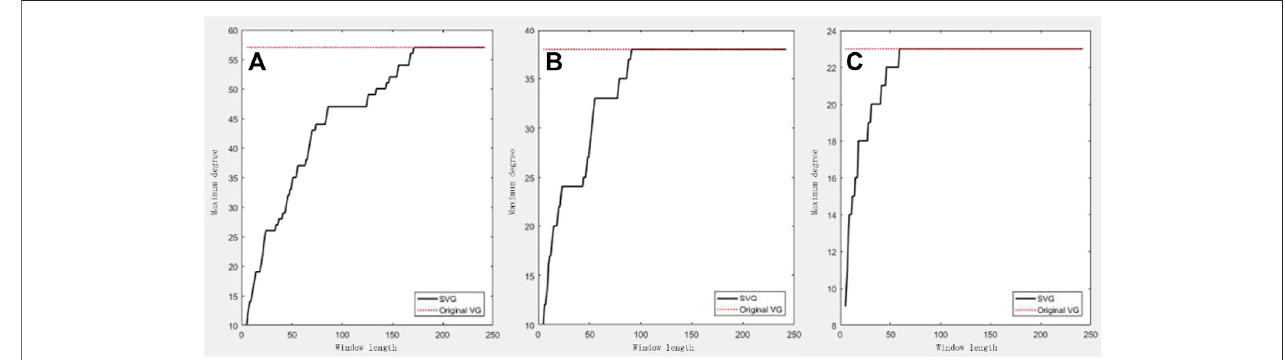
FIGURE4| IllustrationsoftherelationshipsbetweenthemaximumdegreesoftheobtainedcomplexnetworksthroughSVGand W fordifferenttypesoftimeseries data (A) Original data; (B) Brownian Motion incorporated (C) Gaussian white noise considered.